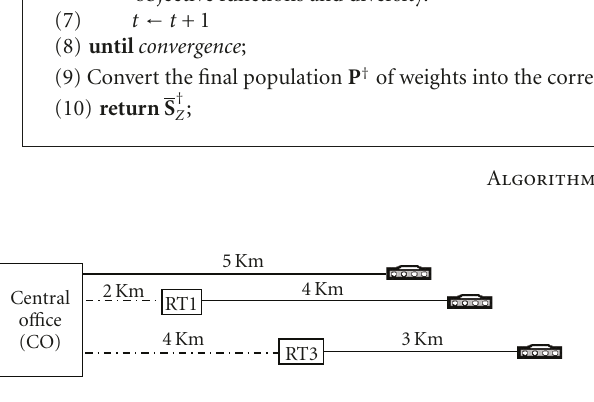
Figure 7: DSL scenario with